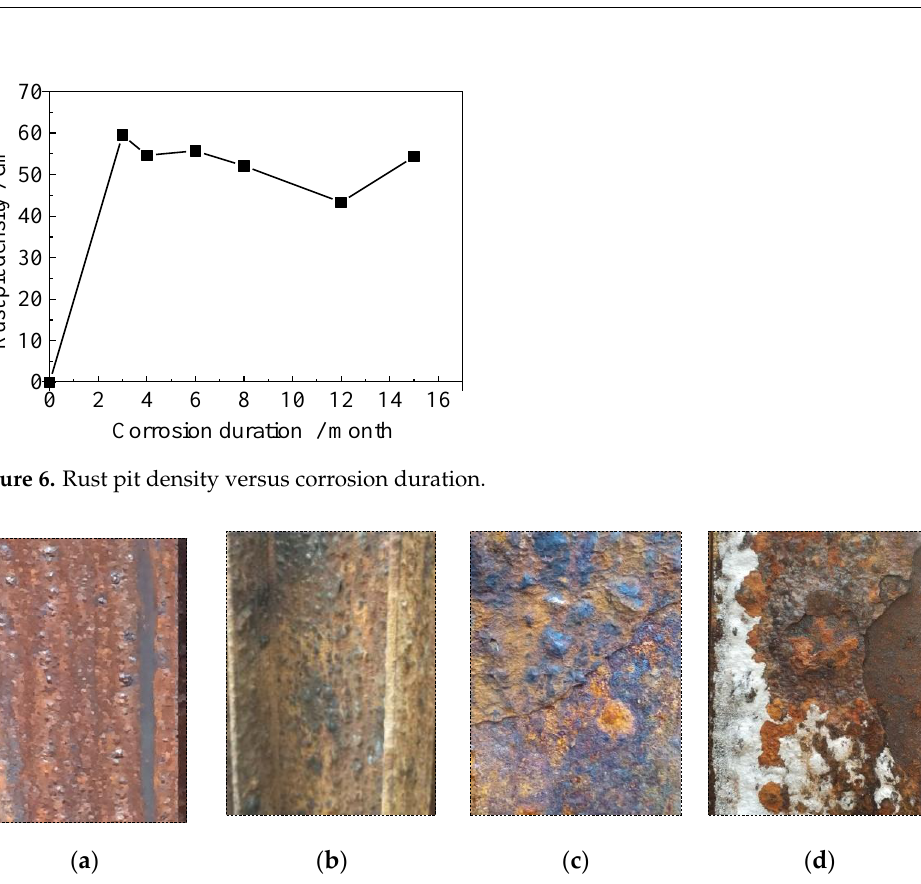
Figure 7. Corrosion morphology of H-shaped steel corresponding to different corrosion durations: